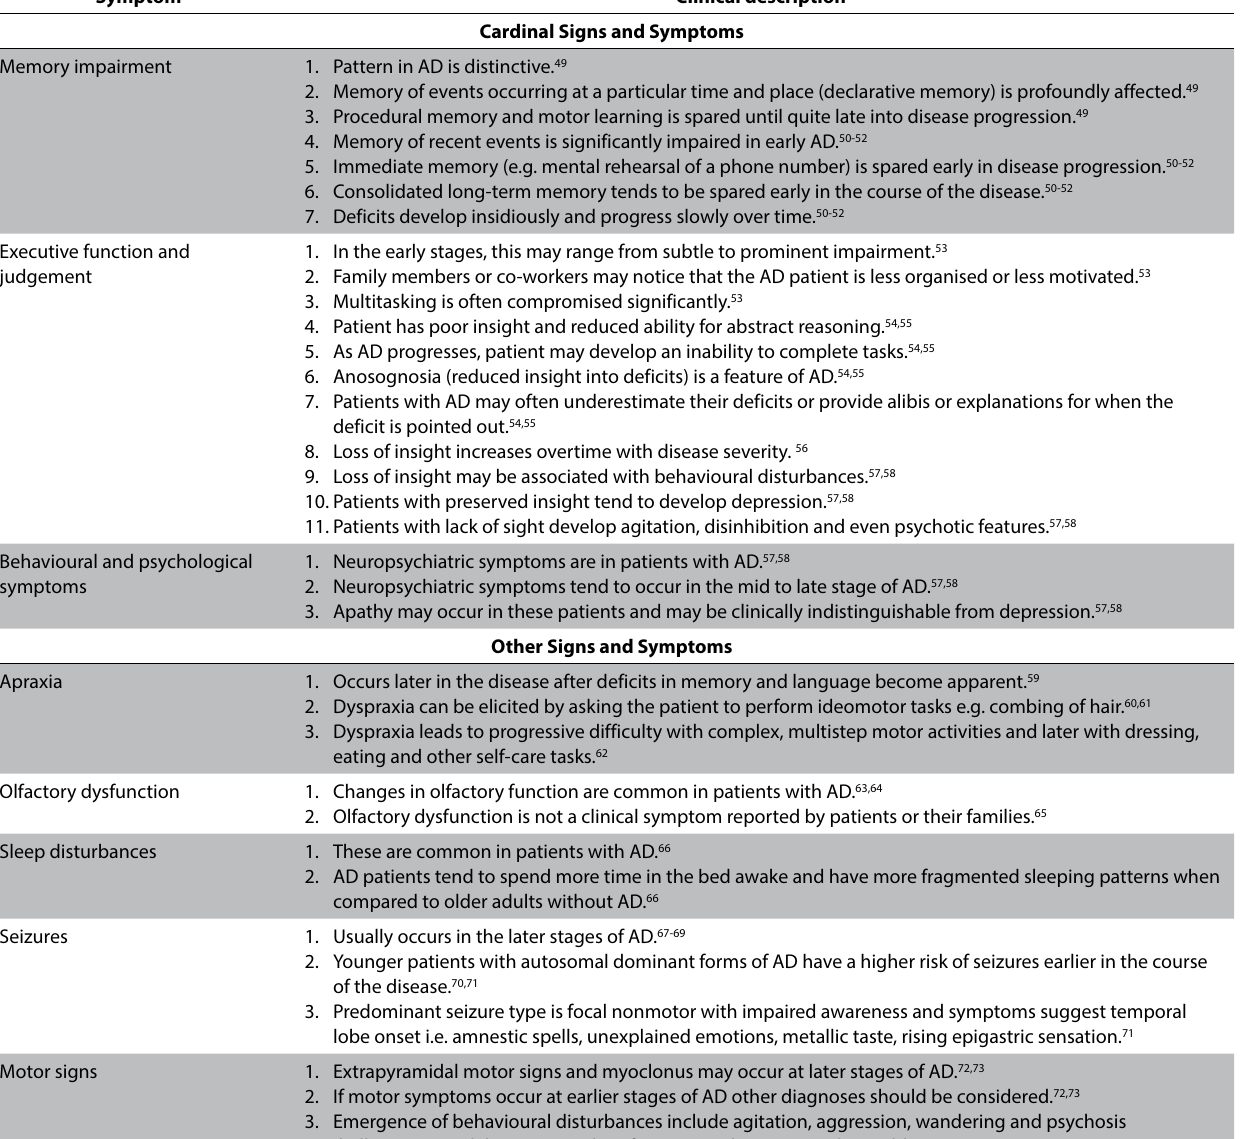
Table II. Signs and symptoms of AD with a clinical description